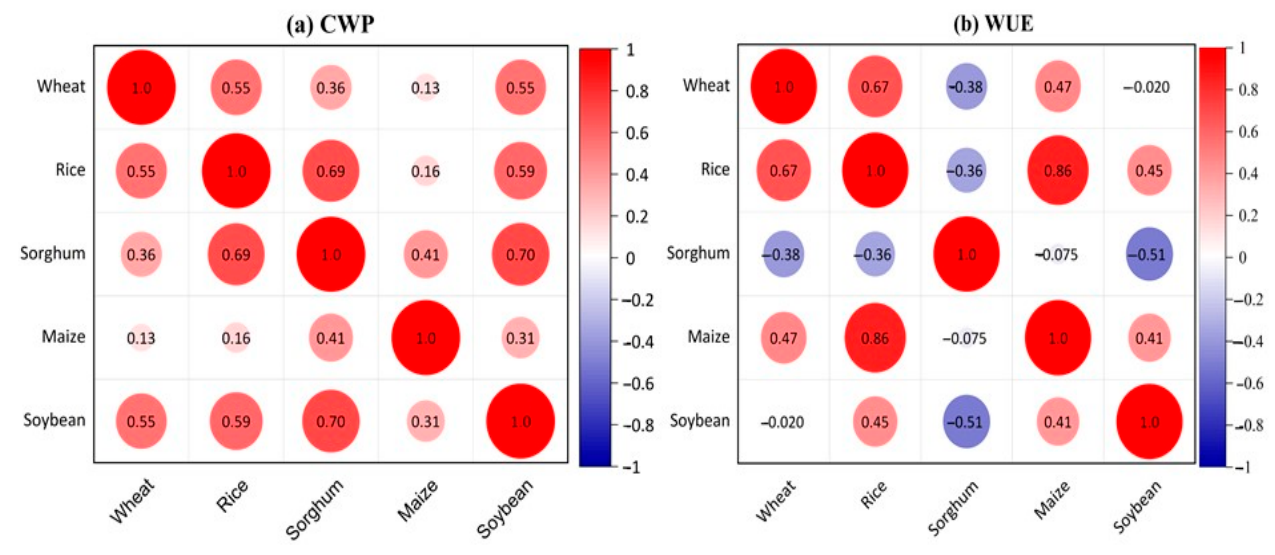
Figure 9. Pearson’s correlation coefficients for the relationship between ( a ) CWP (kg · m − 3 ) and ( b ) WUE (kg.m − 3 ) for the five major crops in NRB during 2009–2020. The diameter of the sphere represents − 1 (i.e., strong negative correlation), 0 (i.e., no relationship), and +1 (i.e., strong positive correlation). Table 4. Average yield and ET values for CWP and WUE in the NRB countries for 2009–2020.